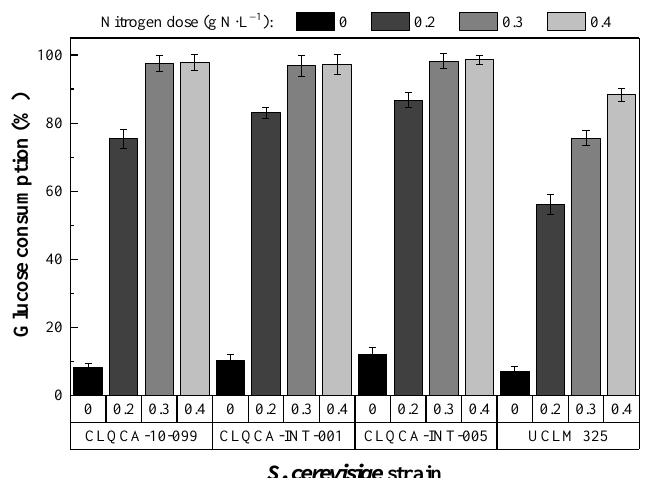
Figure 2. Glucose consumed by the four S. cerevisiae strains under study (CLQCA-10-099, CLQCA-INT-001, CLQCA-INT-005 and UCLM 325) after 24 h of fermentation for different nitrogen supplement doses: 0.2 g N·L −1 , 0.3 g N·L −1 and 0.4 g N·L −1 from yeast hydrolysate; and without nitrogen source. Error bars represent the standard deviation across three replicates.